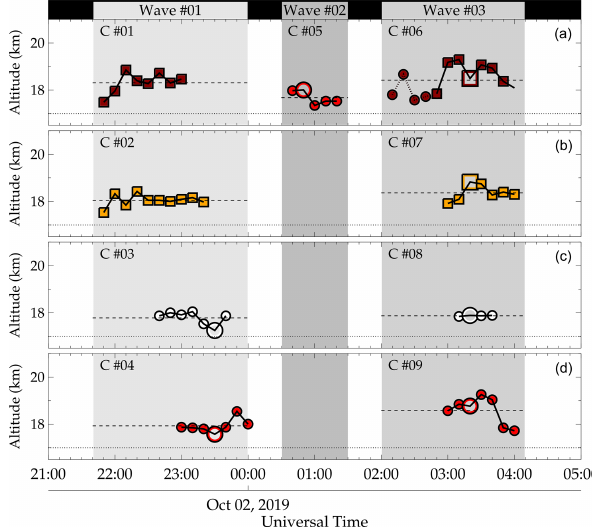
Figure 8. Tracking of overshooting tops in time. Panels (a) – (d) show the temporal variation of the overshooting of convective cores (Cs): no. 01, no. 02, no. 03, and no. 04 for Wave no. 01, C no. 05 for Wave no. 02, and Cs no. 06, no. 07, no. 08, and no. 09 for Wave no. 3. The grayscale regions demarcate the regions for each wave event. The dashed lines show the mean overshooting height of each system, whereas the dotted lines show the mean tropopause height between 29 September and 10 October